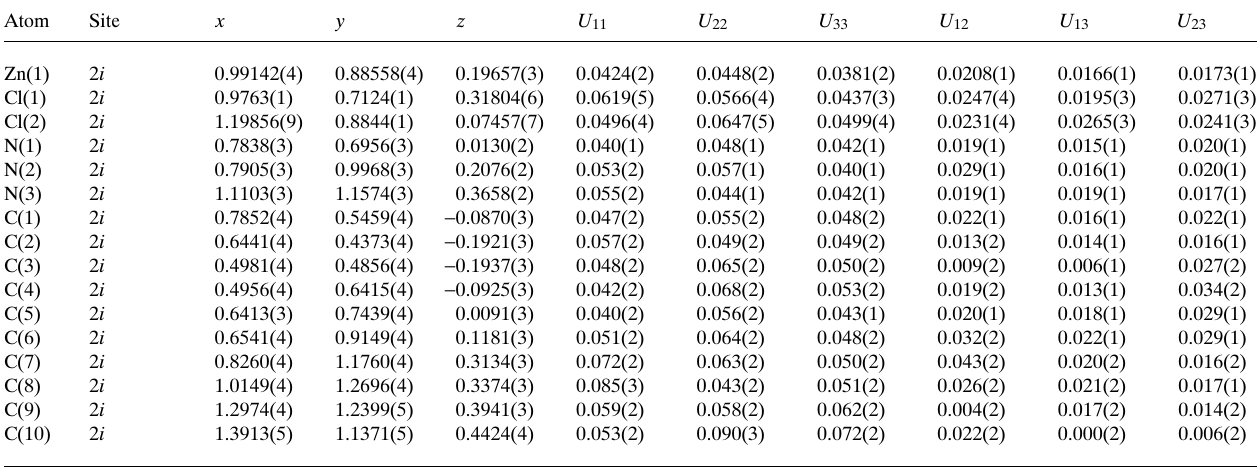
Table 3. Atomic coordinates and displacement parameters (in Å 2 )